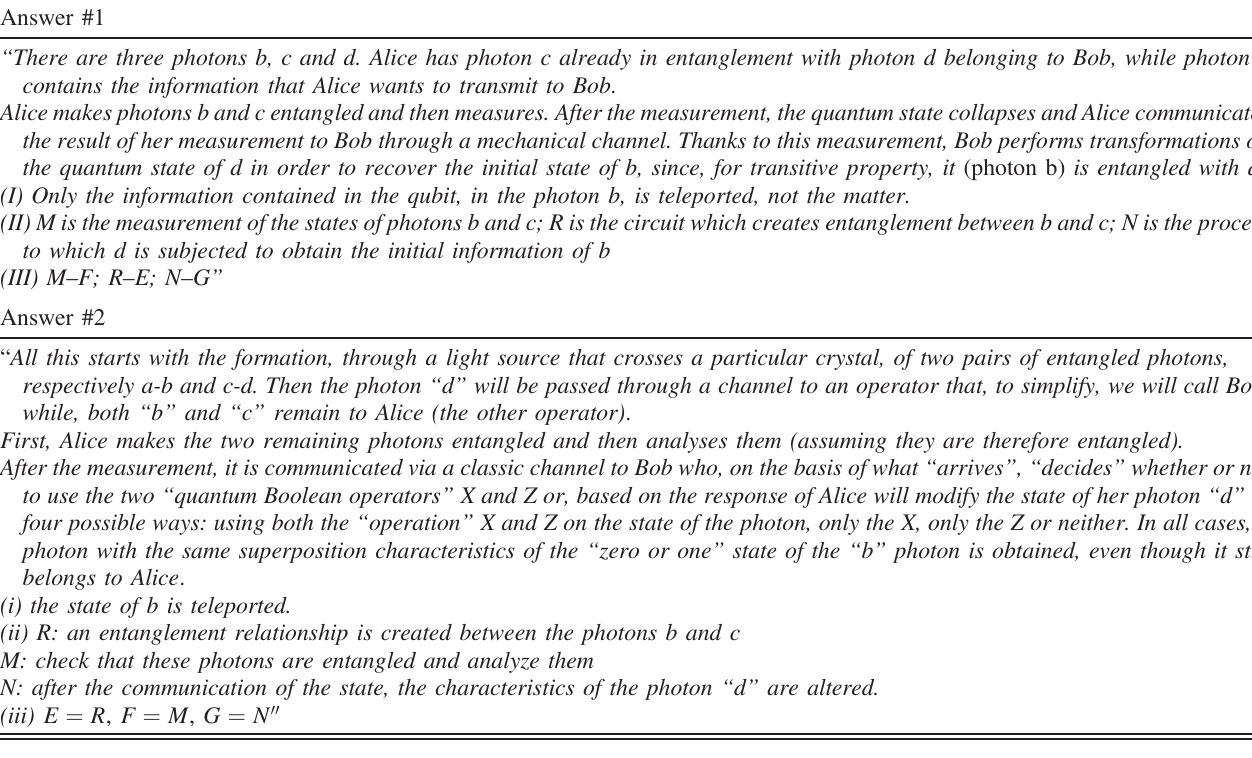
TABLE II. Articulated answers by two